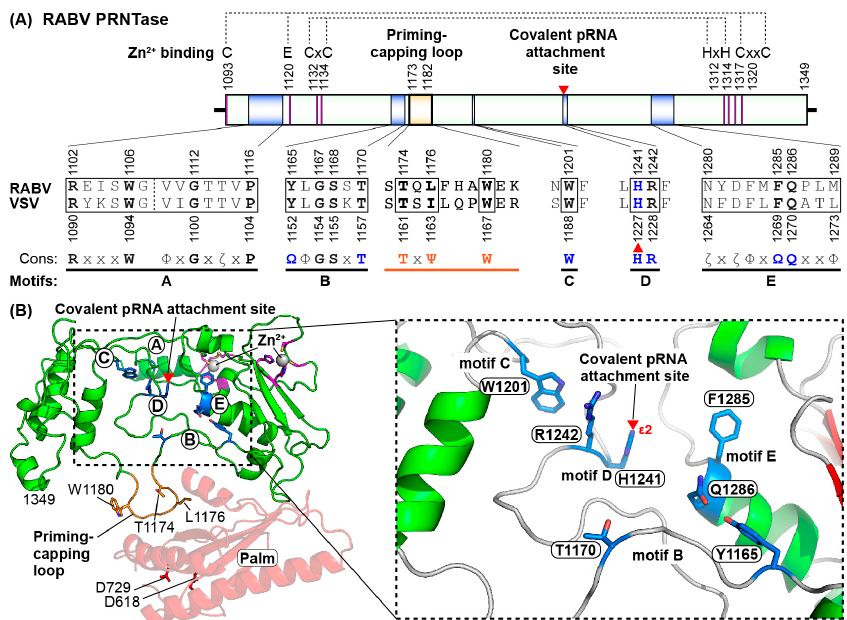
Figure 6. A predicted structure of the GDP polyribonucleotidyltransferase (PRNTase) domain in the rabies virus (RABV) large (L) protein. ( A ) A schematic structure of the RABV PRNTase domain is vesicular stomatitis virus (VSV). Consensus sequences of the PRNTase motifs among nonsegmented negative-strand RNA viruses and the priming-capping loops among animal / arthropod rhabdoviruses are indicated ( Φ , hydrophobic amino acids; other symbols, see